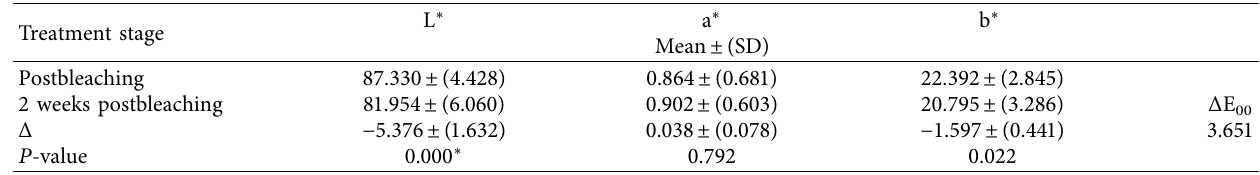
∗ indicates a significant difference between postbleaching and 2 weeks postbleaching values. Table 5: Color difference recorded in L ∗ , a ∗ , and b ∗ values between after restoration and after bleaching and between after bleaching and 2 weeks after bleaching in addition to Δ E